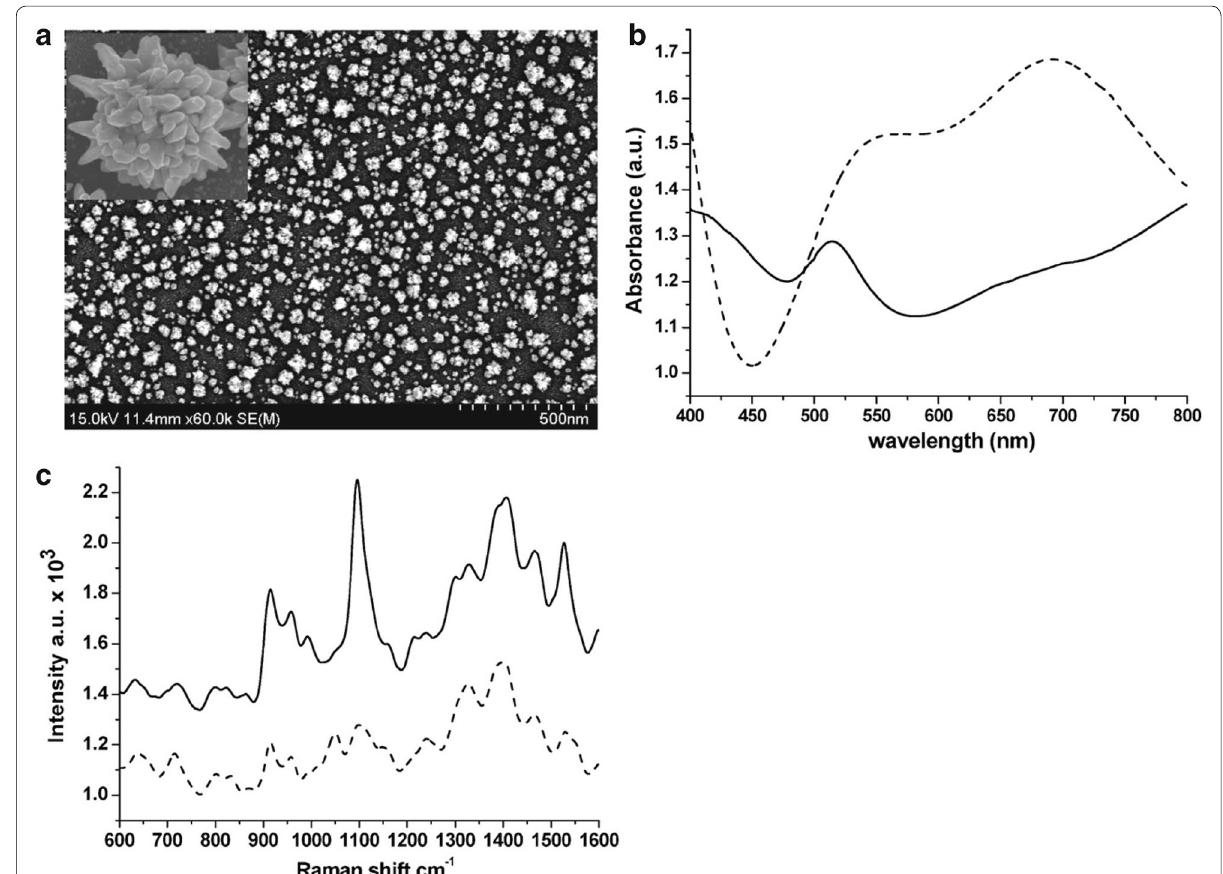
Fig. 6 a SEM topography of Au nanoflower array modified ITO substrate, inset SEM image of single Au nanoflower. b UV–vis spectra of (solid lines) Au spherical nanoparticles/ITO and (dashed lines) Au nanoflower/ITO substrates. c SERS spectra of MUA immobilized on (solid lines) Au nanoflow‑ ers/ITO and (dashed lines) Au nanoparticles/ITO substrates (Reprinted with permission from [38]. Copyright @ 2010